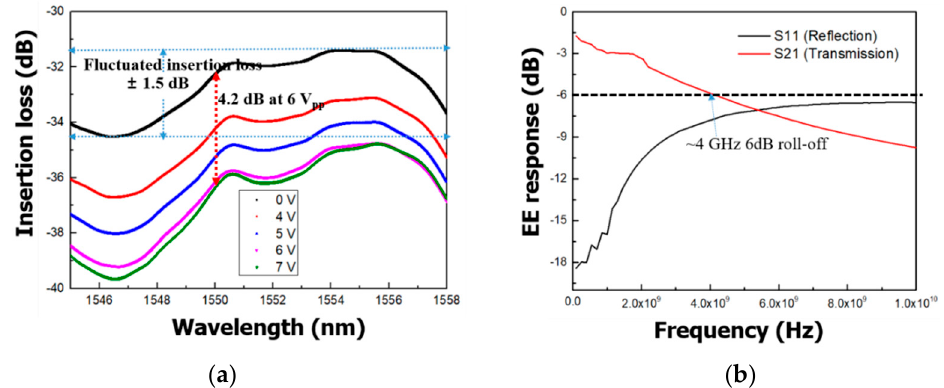
Figure 6. Experimental characteristics of a silicon EAM: ( a ) insertion losses and modulation depths of the EAM; ( b ) electrical response.